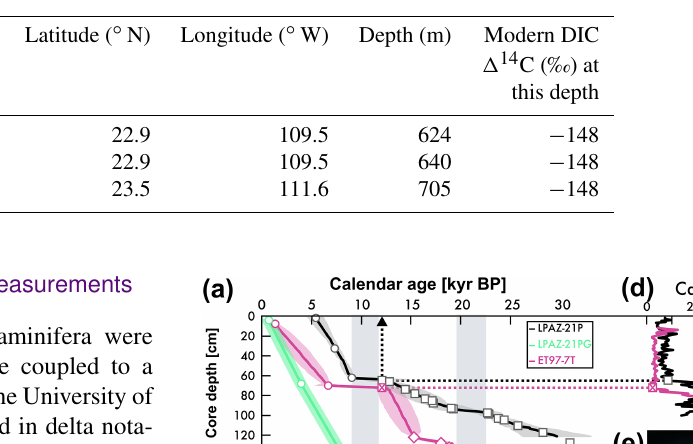
Table 1. Latitude, longitude, depth below modern sea surface, and modern dissolved inorganic carbon (DIC) (cid:49) 14 C (26) at the sediment– seawater interface for sediment cores discussed in this study.